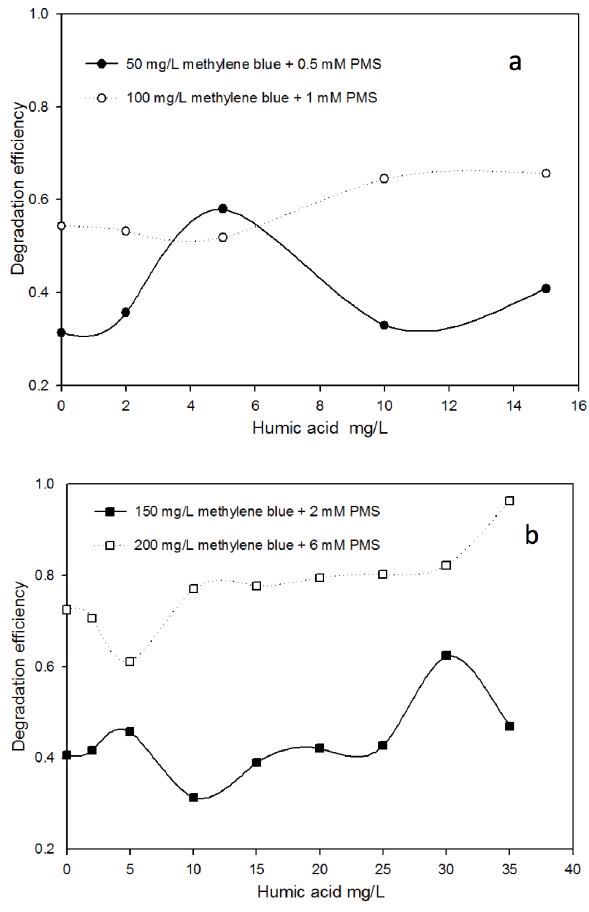
Figure 4 a & b: The effect of humic acid on the degradation of methylene blue using different PMS concentrations for 24 h.